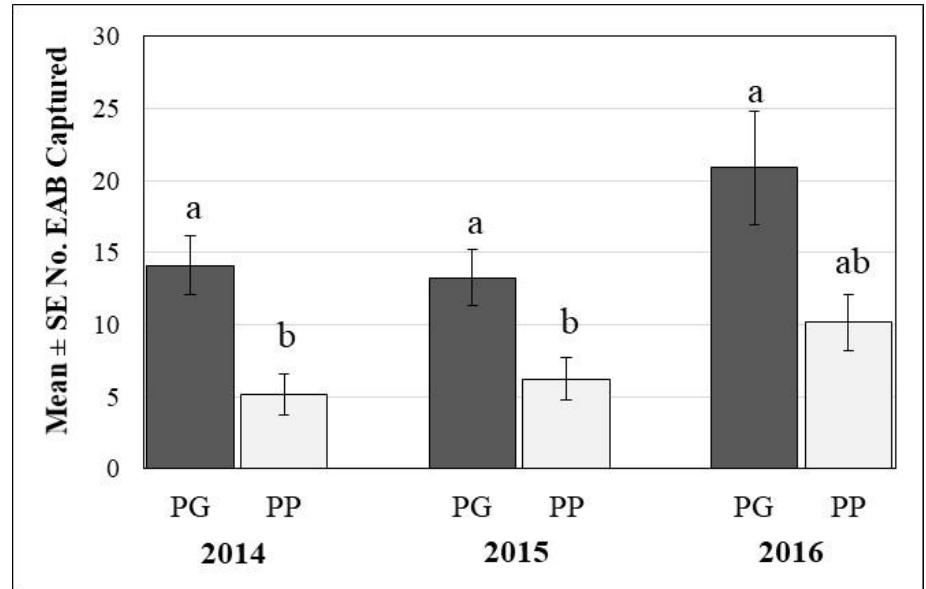
Figure 2. Mean (+SE) number of emerald ash borer adults captured per trap in 2014, 2015, and 2016 on green-purple (GP) double decker (DD) traps and purple-purple (PP) DD traps. Bars topped by the same letter are not significantly different; Tukey-Kramer means comparison procedure, p > 0.05.